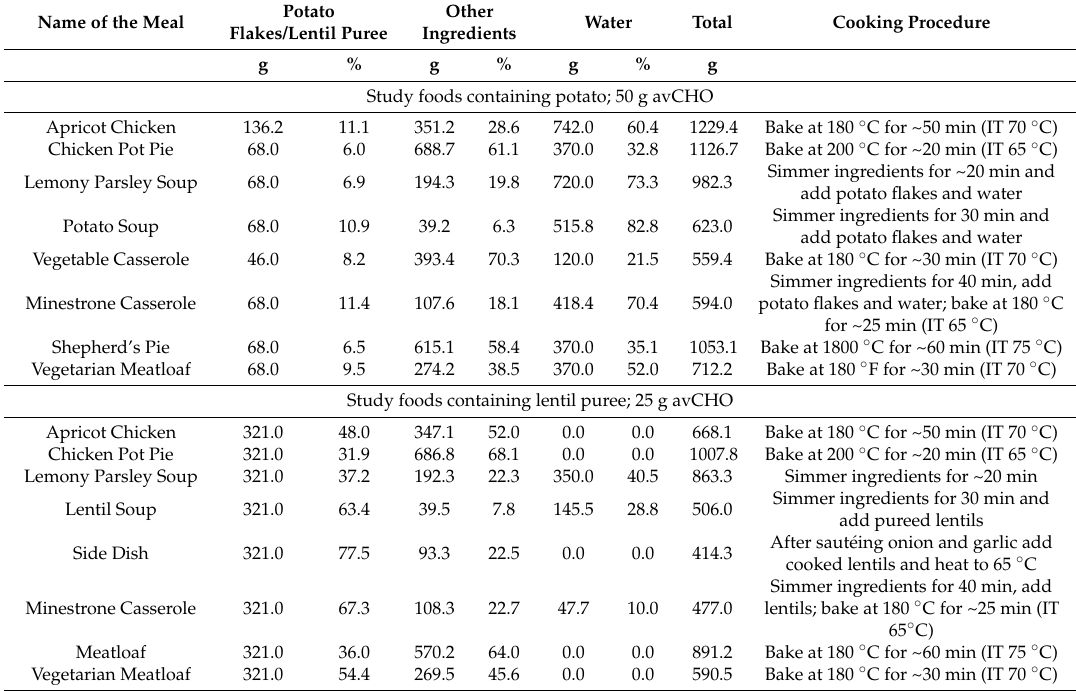
Table 1. Formulations for study foods prepared with lentil puree or